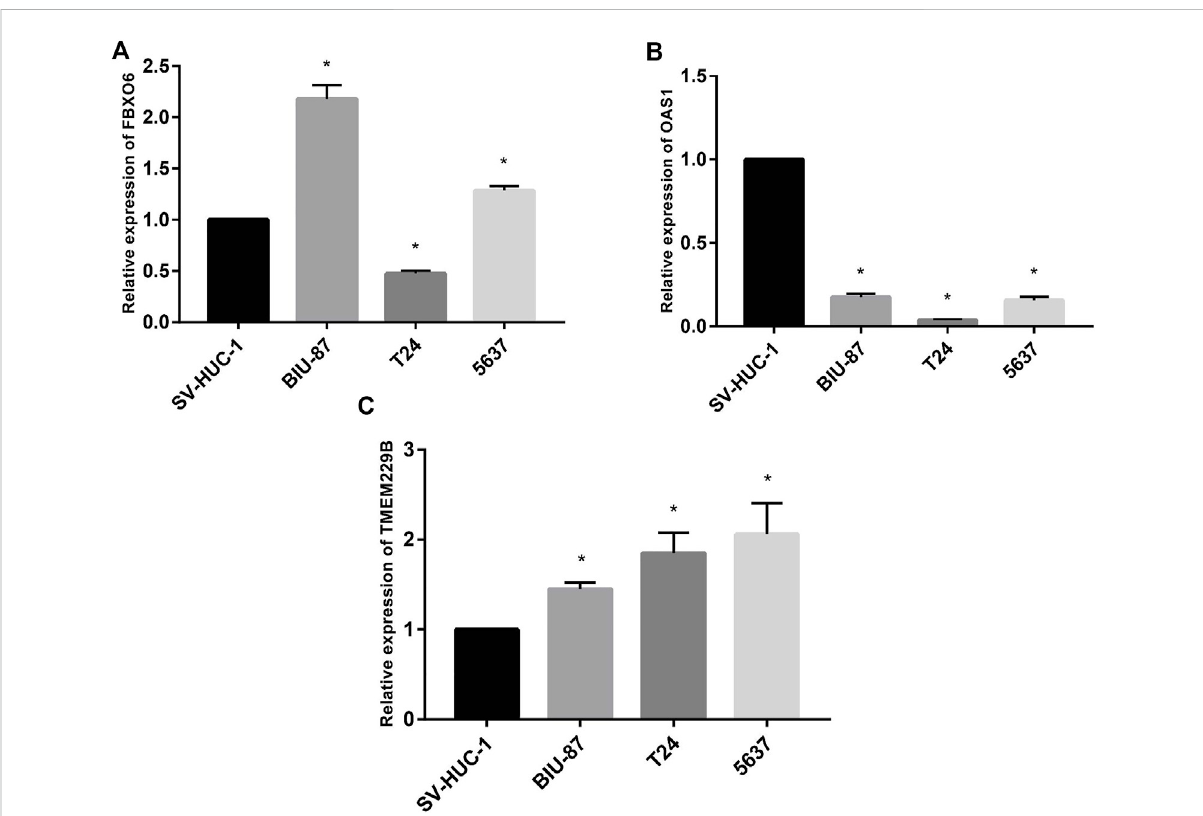
FIGURE 10 (A) The mRNA level of FBXO6 in normal urothelial cell line (SV-HUC-1) and three BLCA cell lines (BIU-87, T24, and 5637) was analyzed by RT- qPCR. (B) The mRNA level of OAS1 in normal urothelial cell line (SV-HUC-1) and three BLCA cell lines (BIU-87, T24, and 5637) was analyzed by RT- qPCR. (C) The mRNA level ofTMEM229B innormal urothelial cell line (SV-HUC-1)and three BLCA cell lines (BIU-87, T24, and 5637) was analyzed by